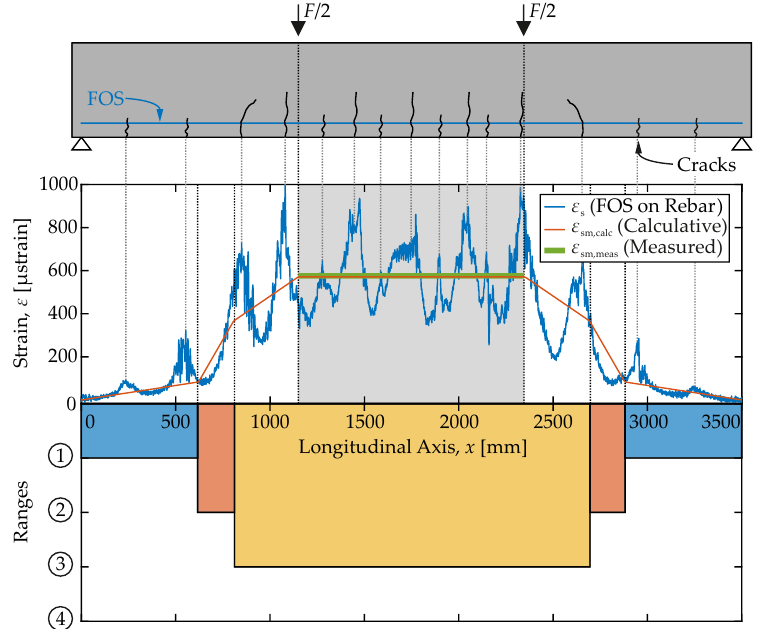
Figure 6. ( Top ): Strain records of the FOS on the flexural reinforcement compared to theoretically expected average steel strains. ( Bottom ): Associated ranges employing the σ s – ε sm —relation on an equivalent load